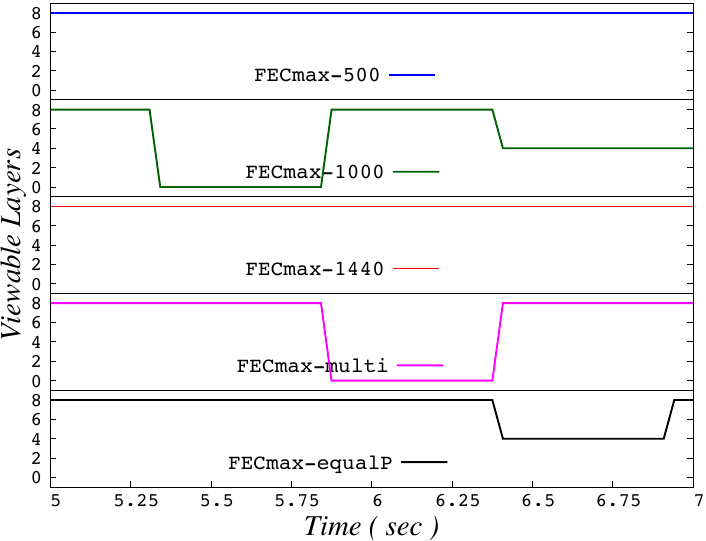
Figure A19. A two-second example of variation in viewable quality for all FEC max schemes, at a packet loss rate of 10% and a GOP of